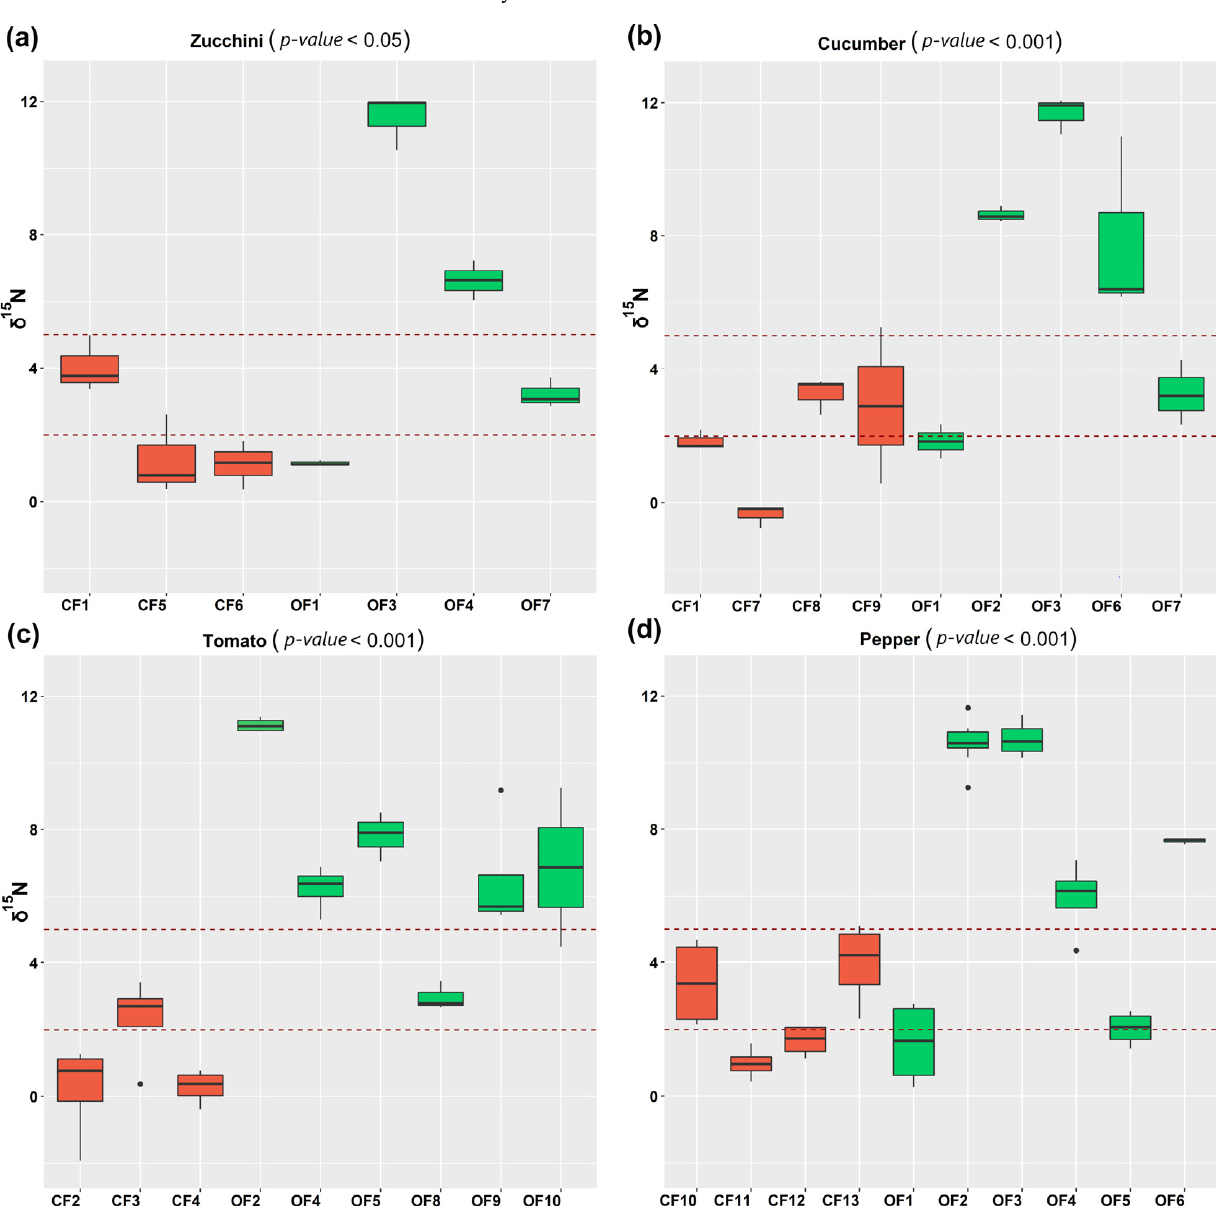
Figure 1. Boxplots of the δ 15 N values measured for the samples from different horticultural crops (a: zucchini; b: cucumber; c: tomato; d: pepper). CF (conventional farmers) and OF (organic farmers). Results from the ANOVA are given for each cultivar.